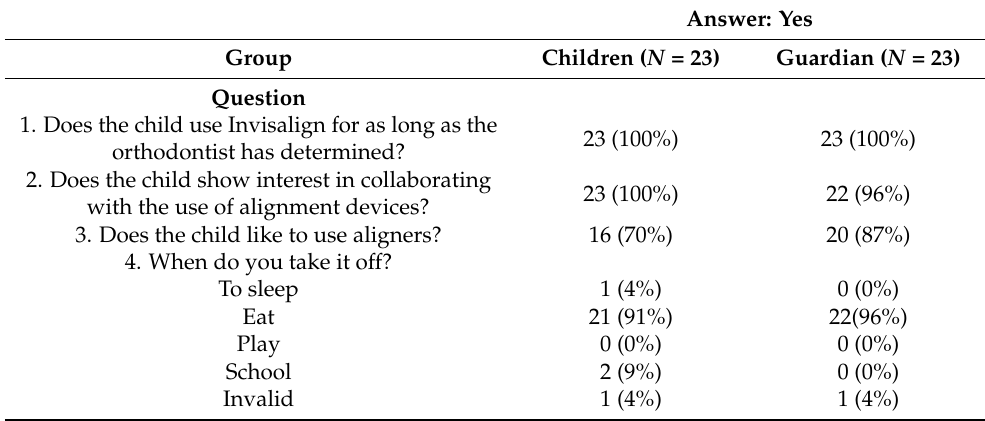
Table 7. Responses to the questionnaires applied to parents and children in treatment with Invisalign ®